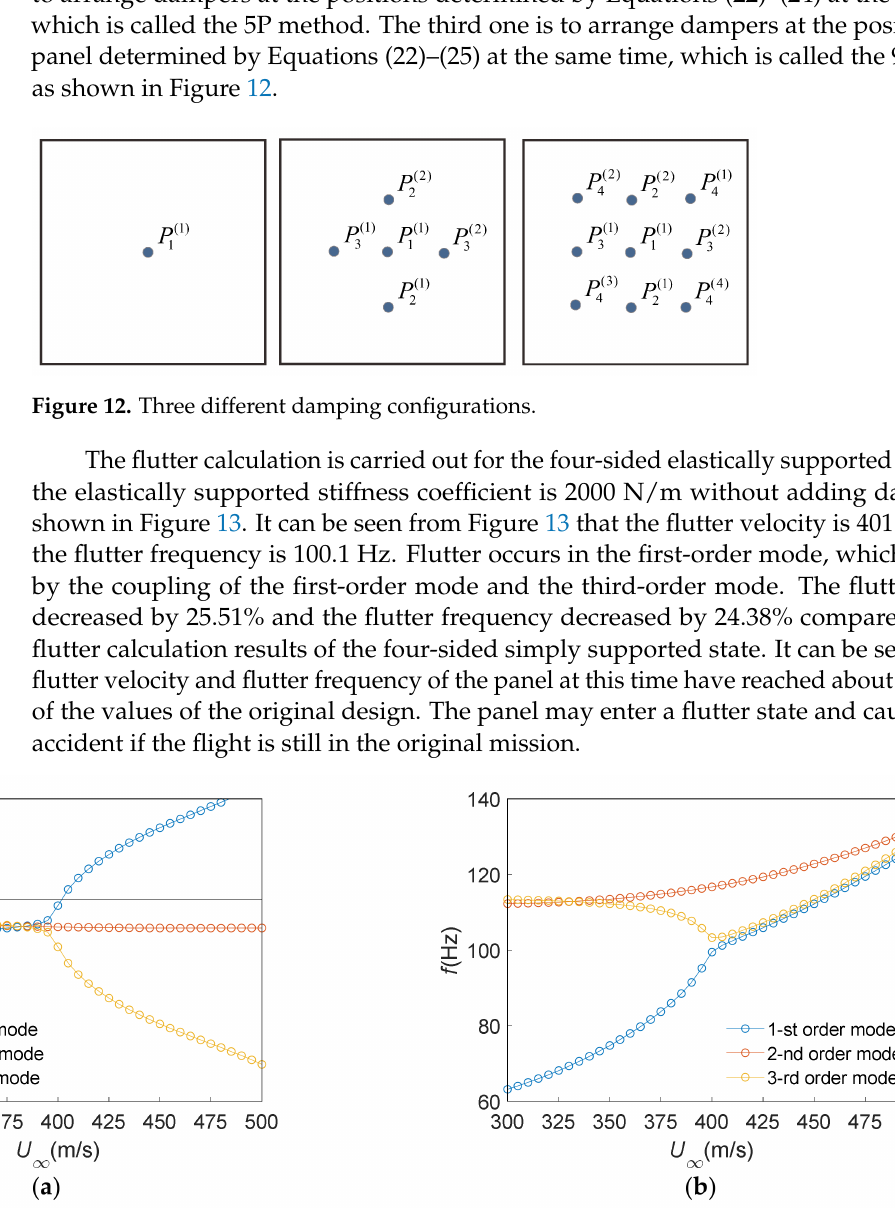
Figure 13. Results of flutter calculation (L4): ( a ) U − g ; ( b ) U − f